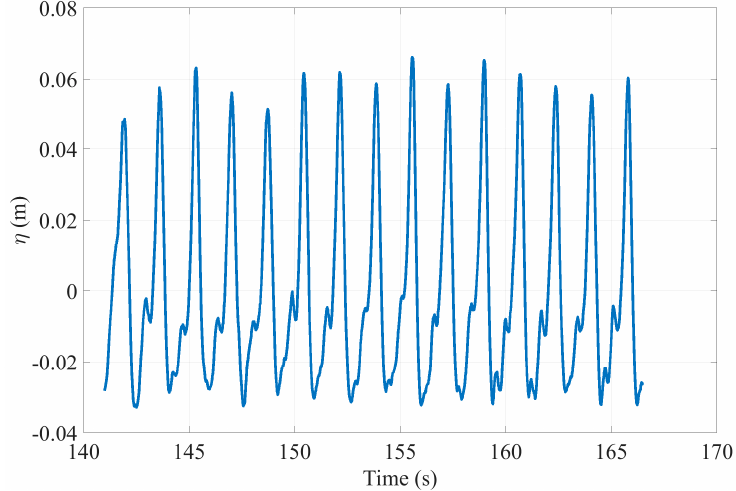
Figure 10. Surface elevation time history of the wave gauge WG7 that was used to test a frozen permafrost specimen.